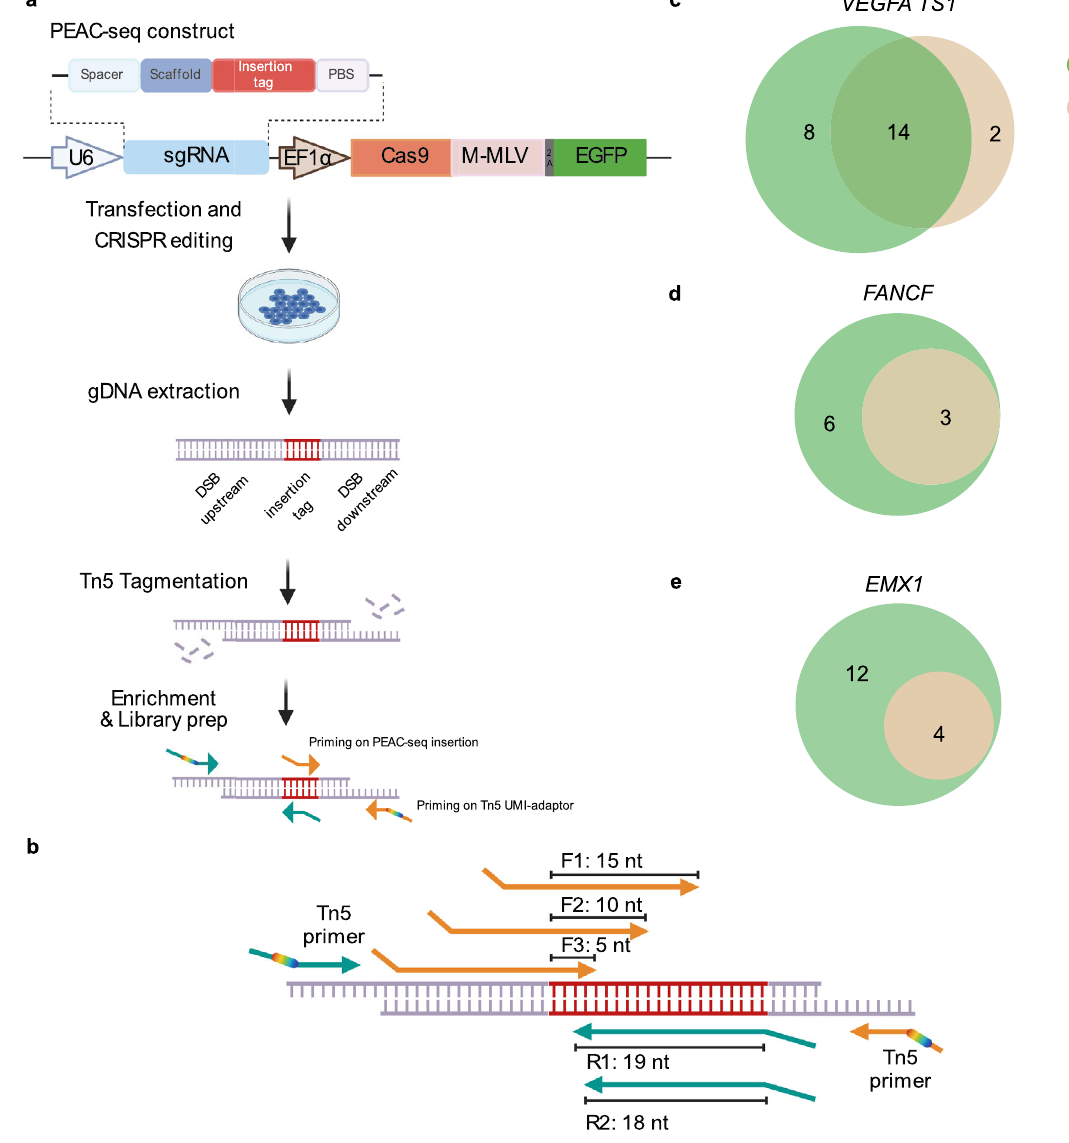
Fig. 1 | Development of the PEAC-seq technique. a Schematic representation of the PEAC-seq experimental procedure. The gDNA was extracted and undergone Tn5 tagmentation. The Tn5 was embedded with UMI adapters to eliminate PCR duplications in silicon. After tagmentation, fragments were ampli fi ed by pairs of primers (one priming at the PEAC-seq insertion, another priming with the Tn5 adapter). b Schematicrepresentationofthethreeforwardprimersandtworeverse primers designed for tag enrichment and library preparation of PEAC-seq. Each forward primer was paired with a downstream Tn5 primer to generate amplicons includingthePEAC-seqtagsequenceanditsdownstreamgenomicsequences.Each